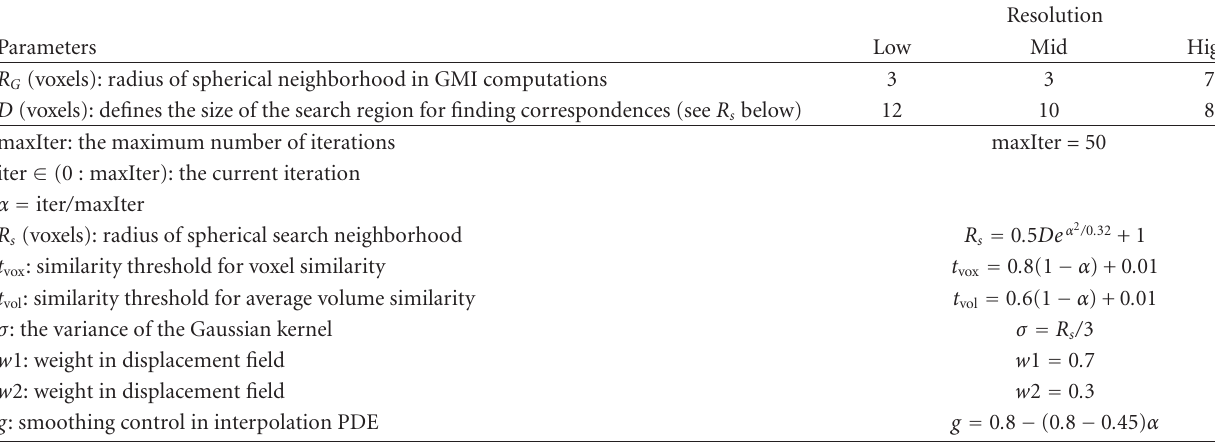
Table 1: Parameters used in Mjolnir in the following